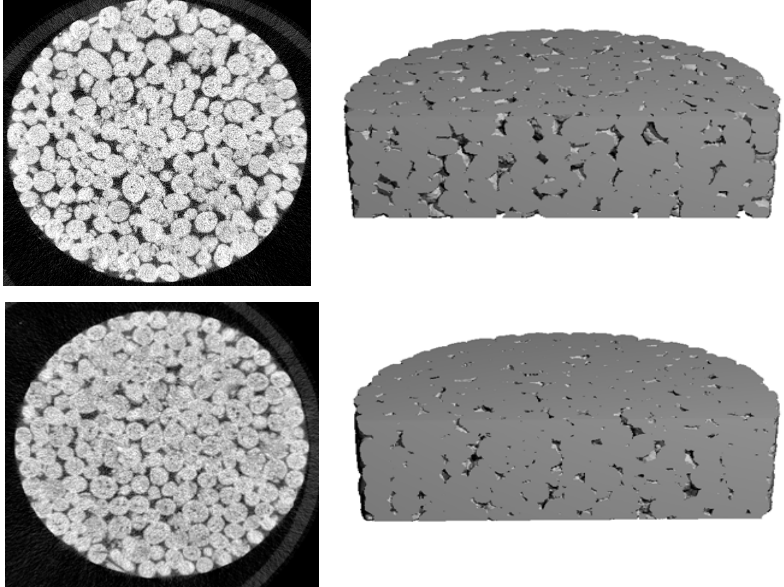
Figure 4. µCT images of preforms compacted at 39 MPa, without sintering (top) and sintered at 730 °C for 4 h (bottom). Left, 2D horizontal section at the mid-plane and right, vertical section of a 3D view at the mid-plane.